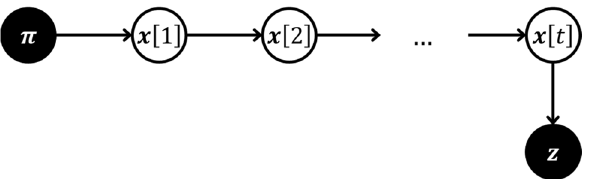
Figure 2. Hidden Markov model with only one observation. π denotes the healthy starting state. Horizontal arcs represent the transitions from a state. ( x [ t − 1] ) to the state at the next time step ( x [ t ] ). The final state is then diagnosed (vertical arc, parametrized via sensitivity and specificity) and we observe z